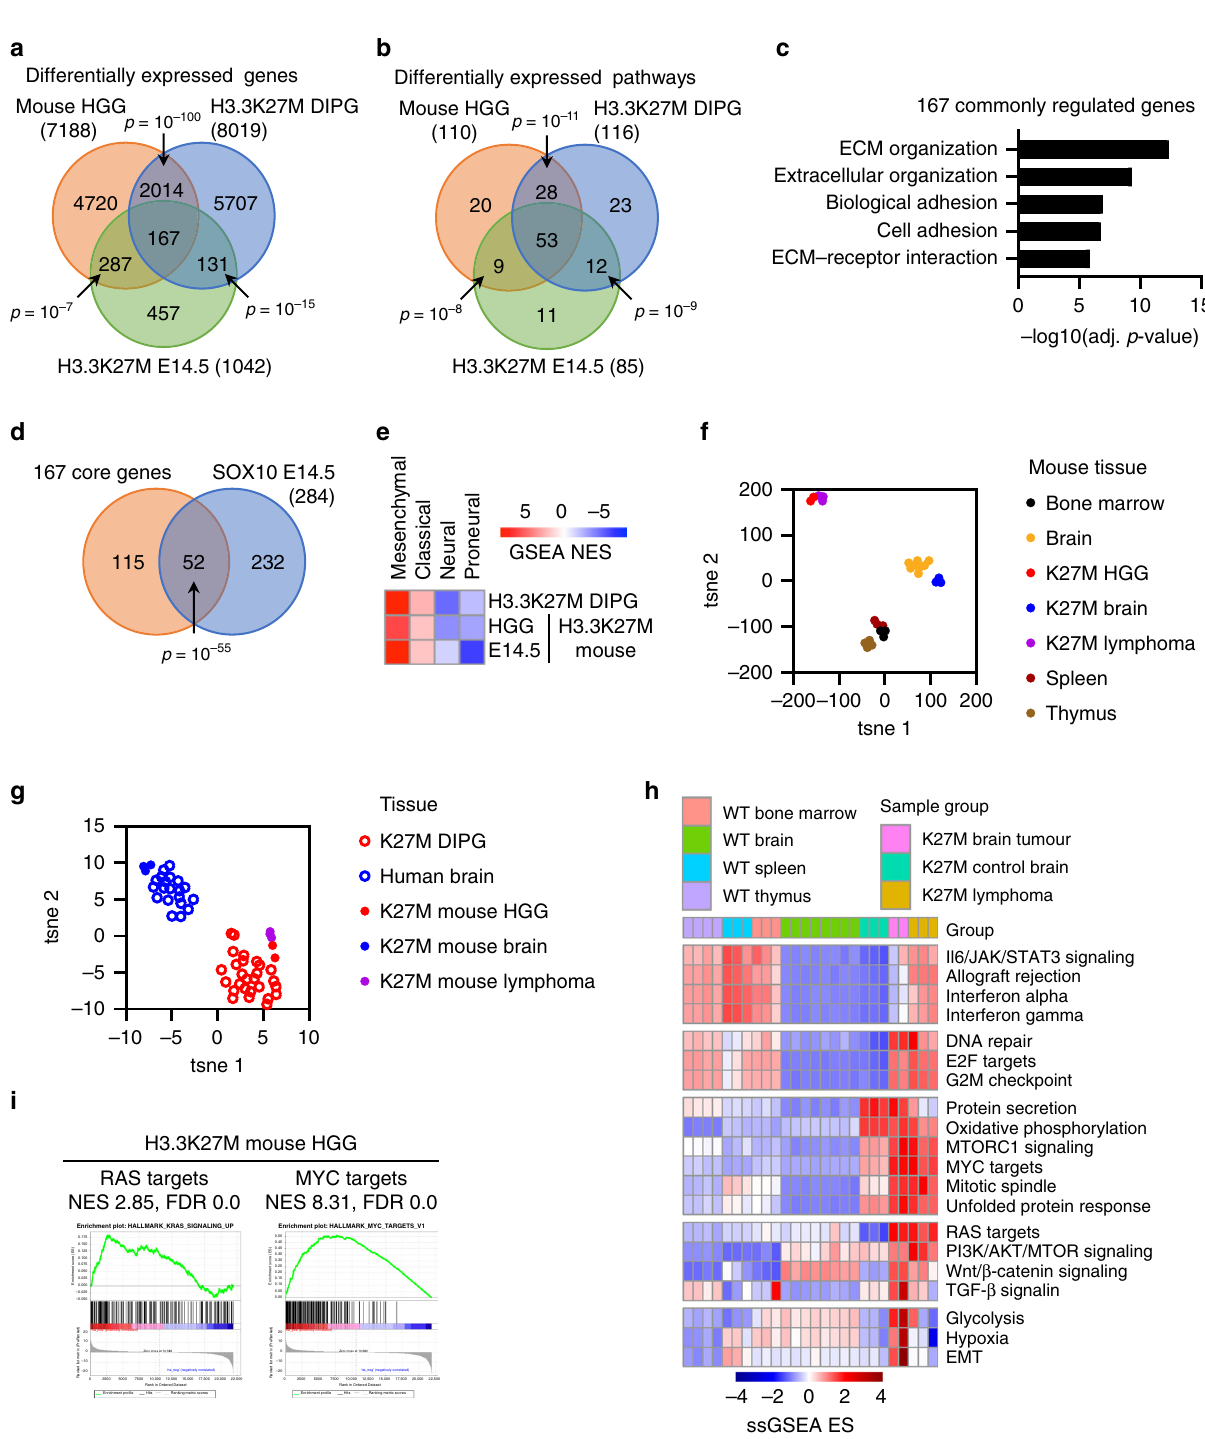
Fig. 4 H3.3K27M drives a lineage independent tumour transcriptome. a Venn diagram comparing differentially expressed genes in H3.3K27M E14.5 MB/ HB and HGG with DIPG. b Venn diagram comparing differentially expressed Hallmark and KEGG pathways in H3.3K27M E14.5 MB/HB and HGG with DIPG. c Gene ontology analysis of 167 genes commonly regulated in B. d Venn diagram showing overlap of 167 genes commonly regulated in B with SOX10 target genes upregulated in E14.5 H3.3K27M MB/HB. e Heatmap showing gene set enrichment analysis (GSEA) normalised enrichment scores (NES) of glioblastoma subtype signatures. f t-SNE of wild type tissues (bone marrow, spleen, thymus, brain) and untransformed brain, brain tumours and lymphomas from H3.3K27M mice. g t-SNE of untransformed brain, brain tumours and lymphomas from H3.3K27M mice and human H3.3K27M DIPG and normal brain. h Heatmap of select single sample GSEA (ssGSEA) hallmark enrichment scores (ES). i GSEA of RAS and MYC target genes in H3.3K27M mouse HGG. FDR: false discovery rate. Source data are provided as a Source Data fi le. Statistical tests: Hypergeometric ( a , b , d